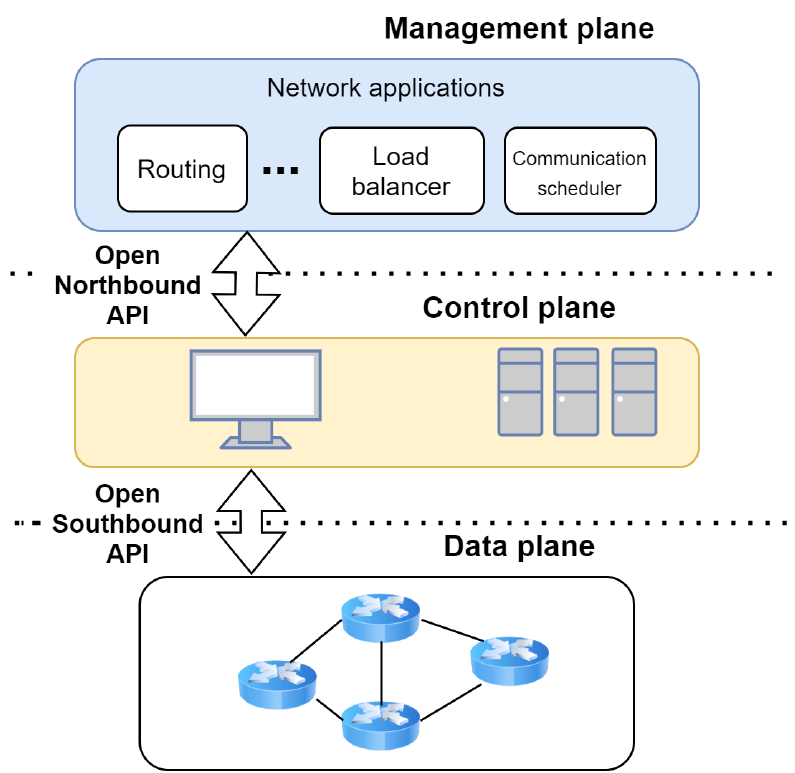
Figure 1. Simplified view of SDN